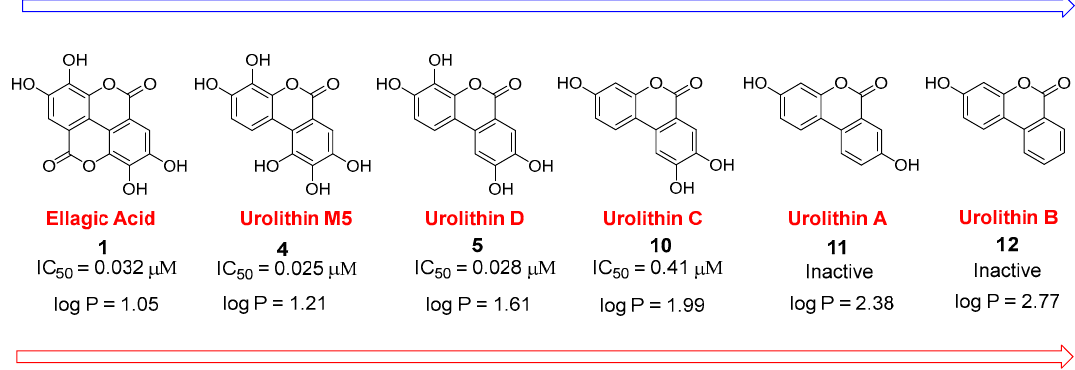
Figure 3 . EA metabolites and corresponding IC 50 vs. PKL. Figure 3. EA metabolites and corresponding IC